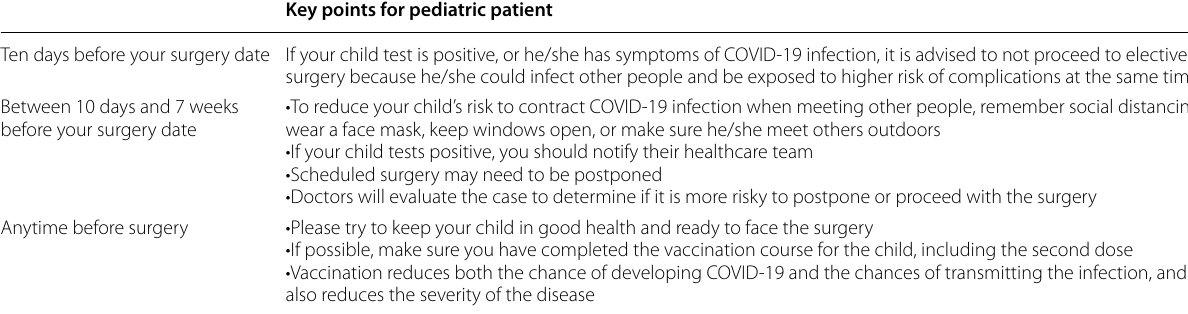
(E-Table 4 in the Additional file 1: Pediatric patient risk assessment process)